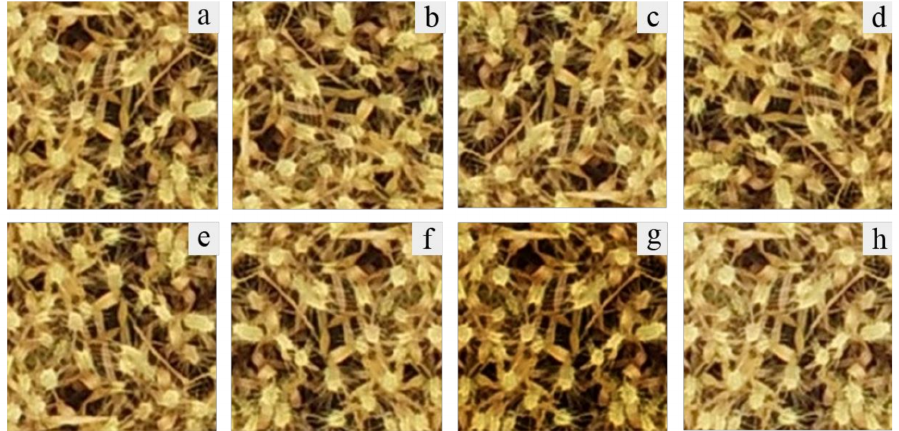
Figure 3. Data augmentations: ( a ) original image, ( b ) rotate 90 ◦ , ( c ) rotate 180 ◦ , ( d ) rotate 270 ◦ , ( e ) vertical flip, ( f ) horizontal flip, ( g ) and ( h ) luminance